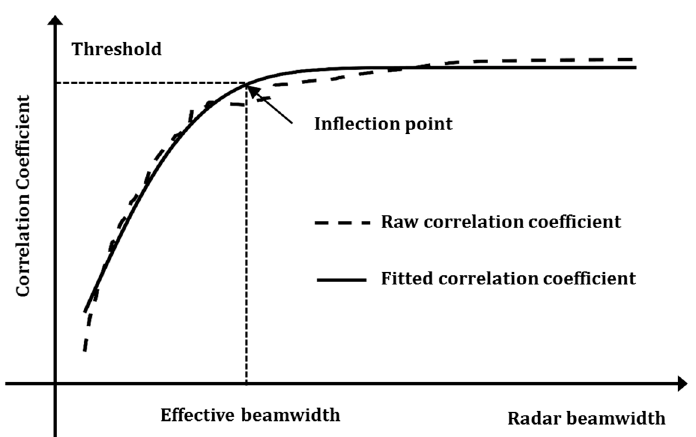
Figure 6. The schematic distributions of correlation coefficients versus radar beamwidth. The dashed line and solid line represent the raw and fitted correlation coefficients, respectively.